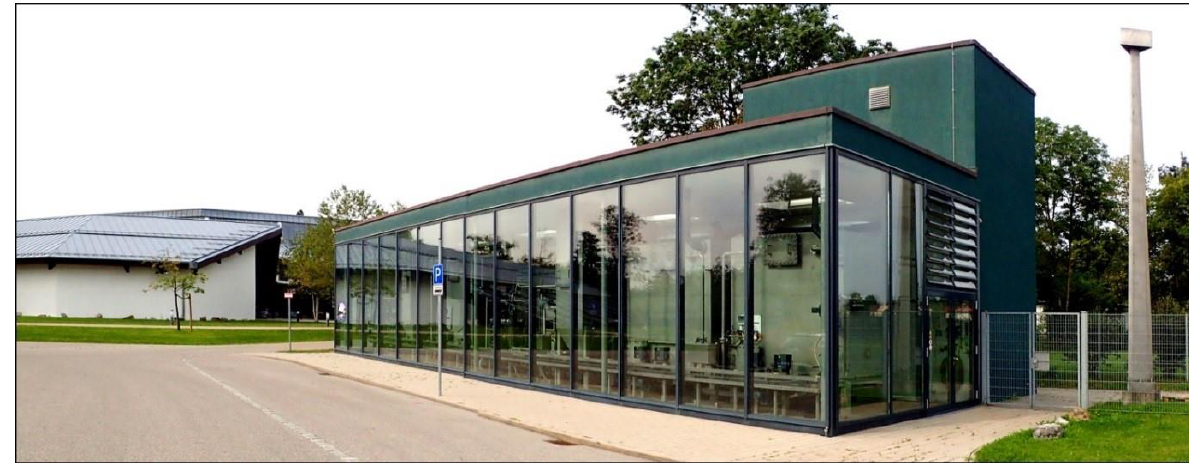
Figure 7. The building housing the borehole used to extract mineral thermal waters in Bad Aibling. The building is located near the entrance zone of the health resort and makes it possible to observe the mining process of groundwater extraction Bad Schandau represents a broader group of German health resorts in which the function of mining is not particularly exposed or highlighted in urban space. At the same time, locally extracted groundwater is used to a wide extent - both in medicinal therapies offered by the health resorts, as well as for recreational purposes. The contemporary complex of thermal baths used not only by patients, but also by numerous tourists, stands out in the structure of the town. Matters associated with mining, geology and geochemistry are only briefly mentioned in information brochures available in the main building of the baths - we can therefore assume that general awareness concerning these matters is rather limited. Mining elements are not particularly exposed in urban space, which means that they do not take an active part in shaping its attractiveness.